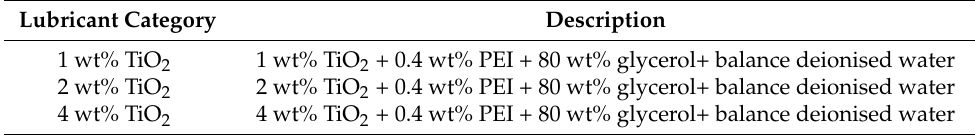
Table 3. Various compositions of